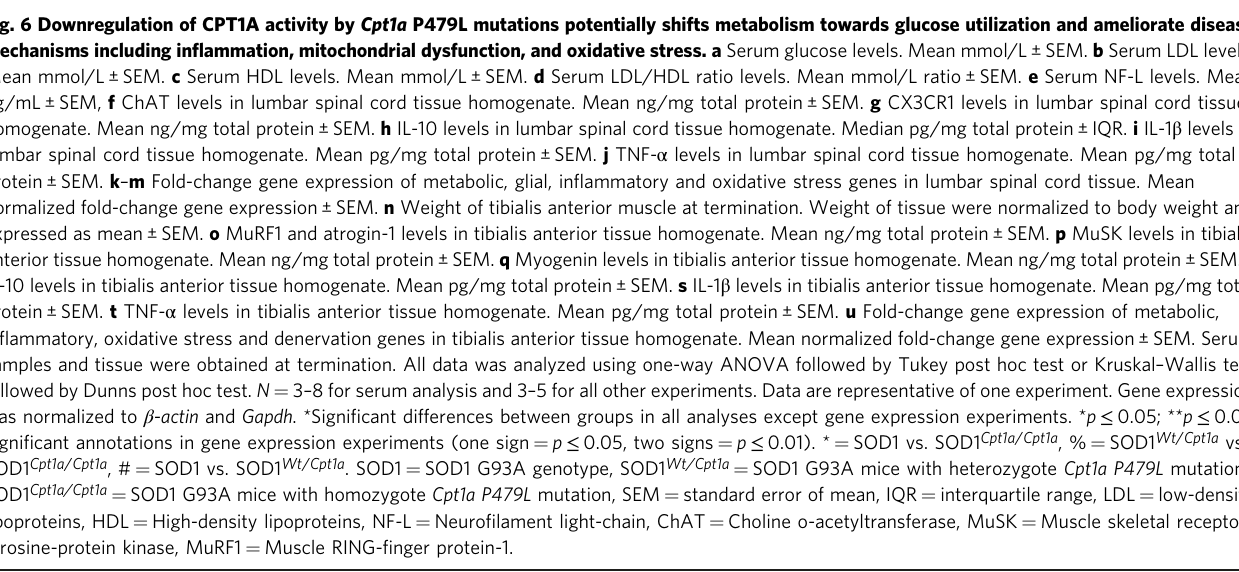
Fig. 6 Downregulation of CPT1A activity by Cpt1a P479L mutations potentially shifts metabolism towards glucose utilization and ameliorate disease mechanisms including in fl ammation, mitochondrial dysfunction, and oxidative stress. a Serum glucose levels. Mean mmol/L± SEM. b Serum LDL levels. Mean mmol/L ± SEM. c Serum HDL levels. Mean mmol/L± SEM. d Serum LDL/HDL ratio levels. Mean mmol/L ratio ± SEM. e Serum NF-L levels.